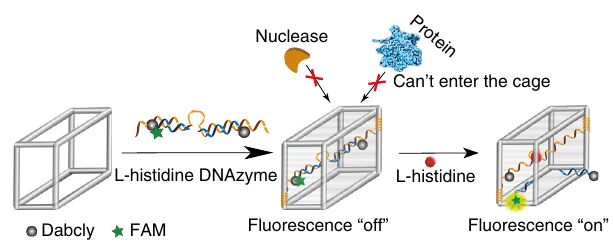
Fig. 2 Scheme illustration of CONFINED-DNAzyme. The design of DNAzyme encapsulated in a cavity-tunable framework